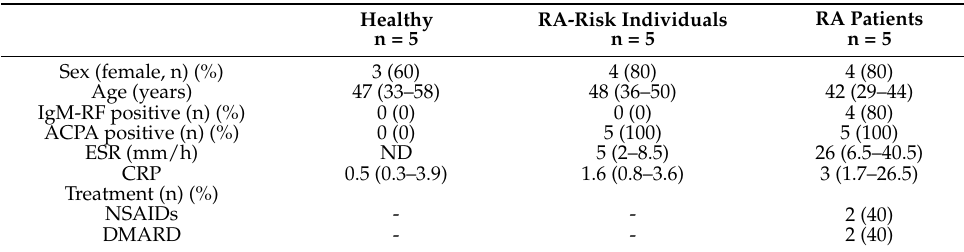
Table 1. Demographic baseline characteristics of study